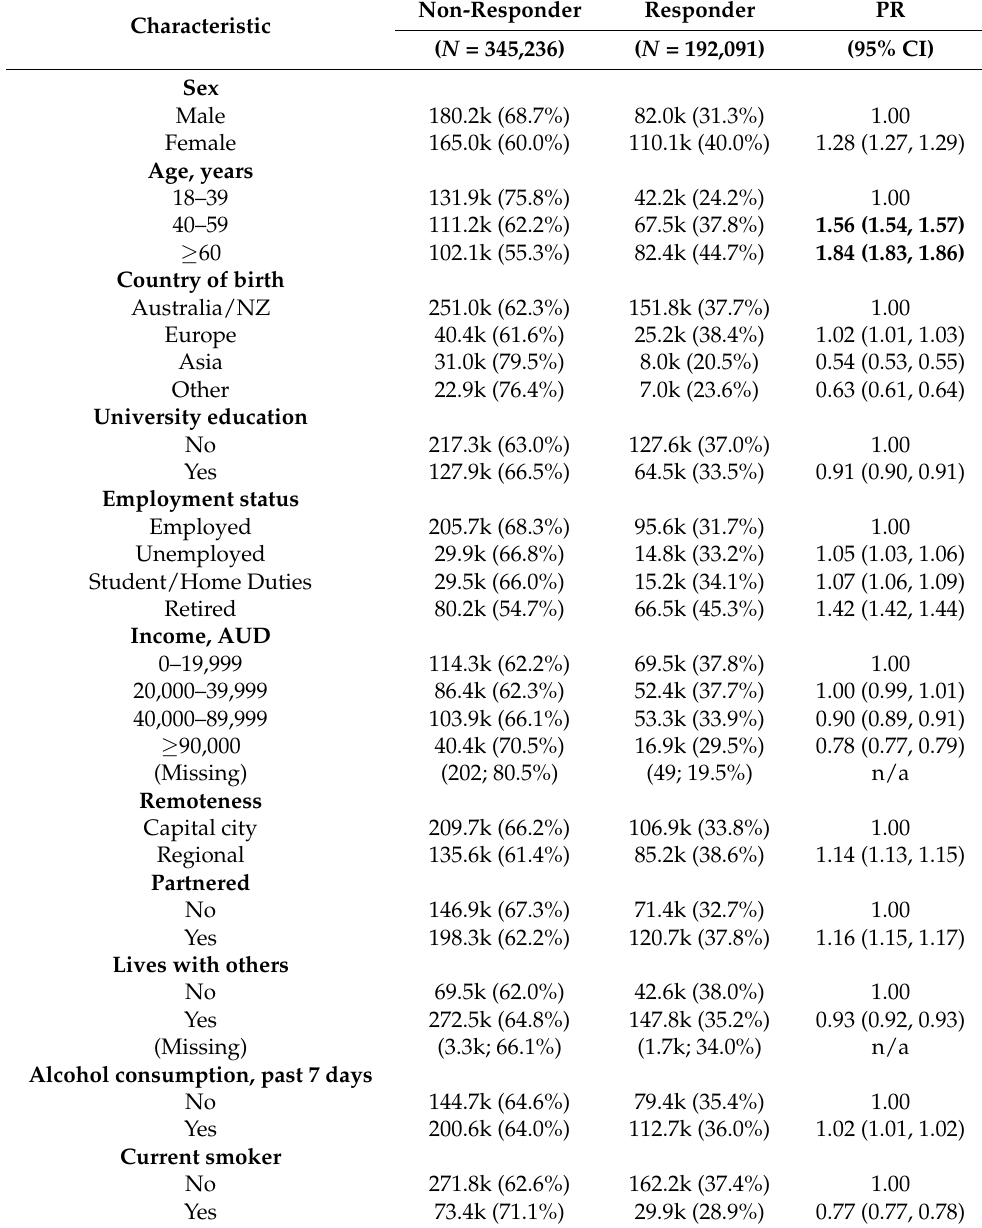
Table 2. Characteristics of single source survey non-responders and